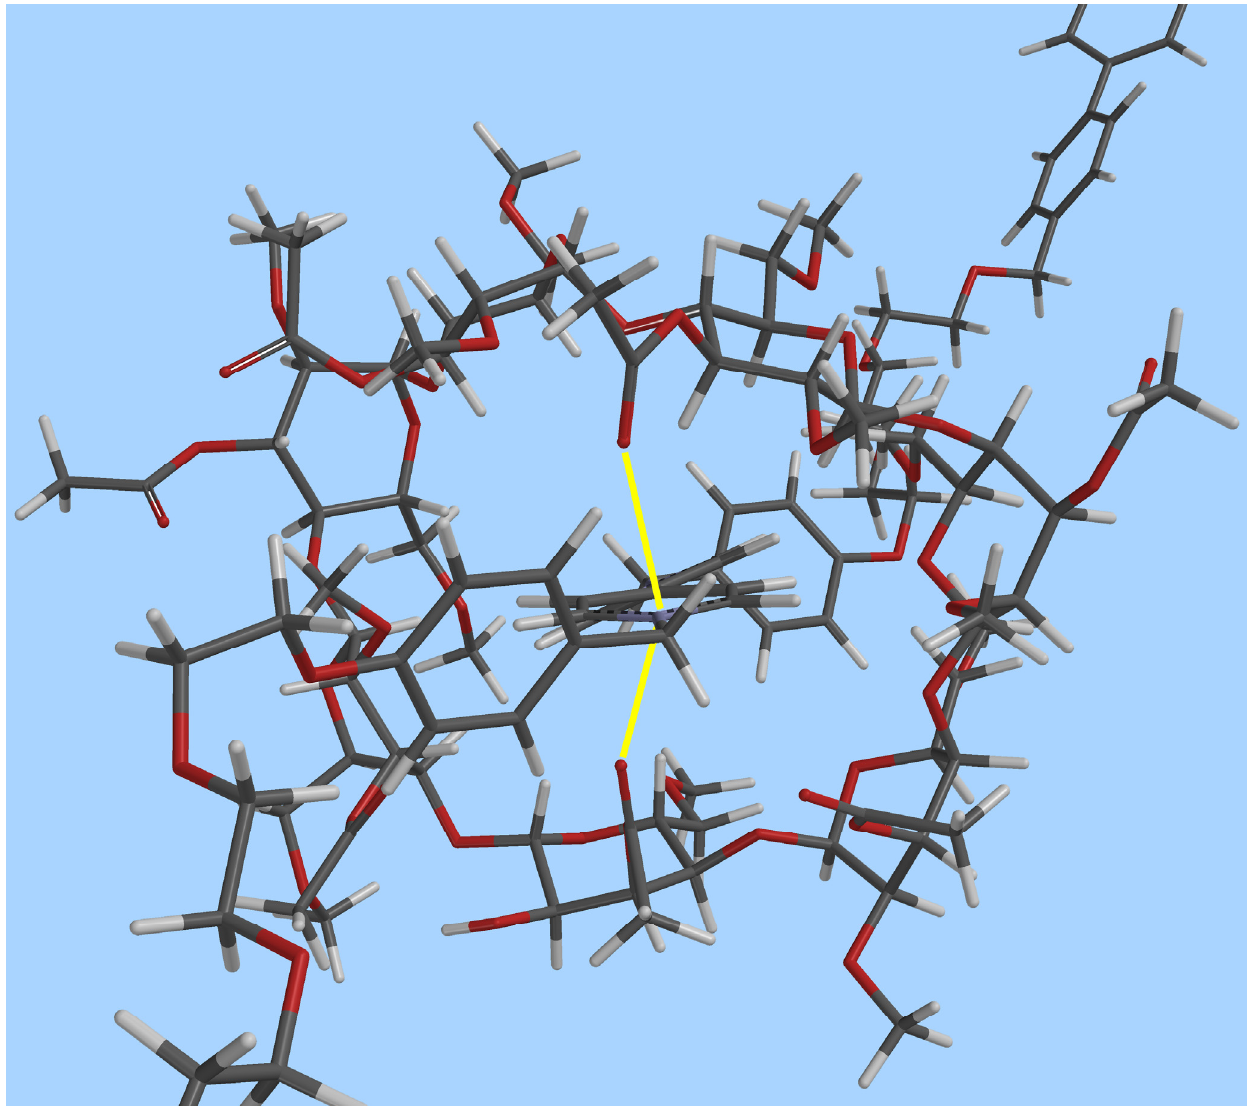
Figure 4. Top-down view of the CD cavity in the [2]pseudorotaxane 1 ⊃ 2 ⋅ 2Cl. O ⋅⋅⋅ N + interactions are highlighted in yellow (grey: carbon, white: hydrogen, red: oxygen; chloride ions omitted for